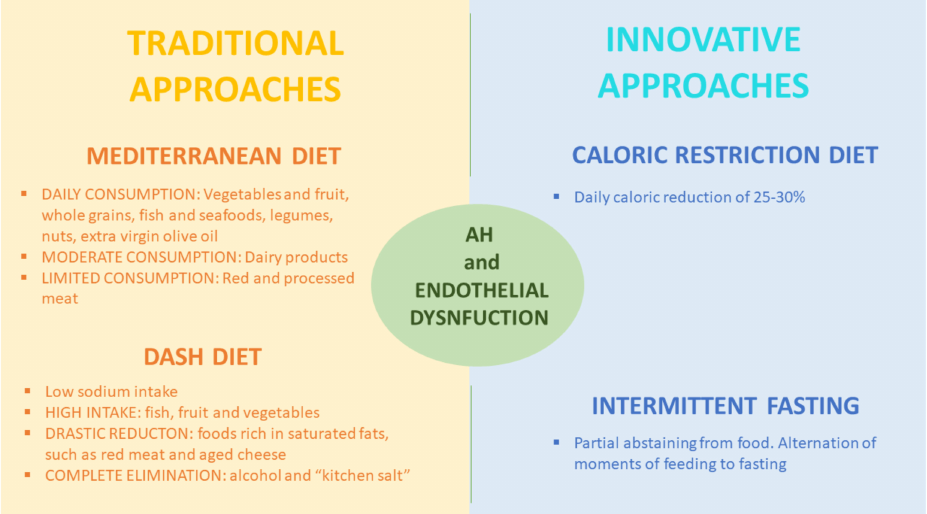
Figure 4. Traditional vs. innovative nutritional approaches for arterial hypertensions and endothelial dysfunction treatment. AH, arterial